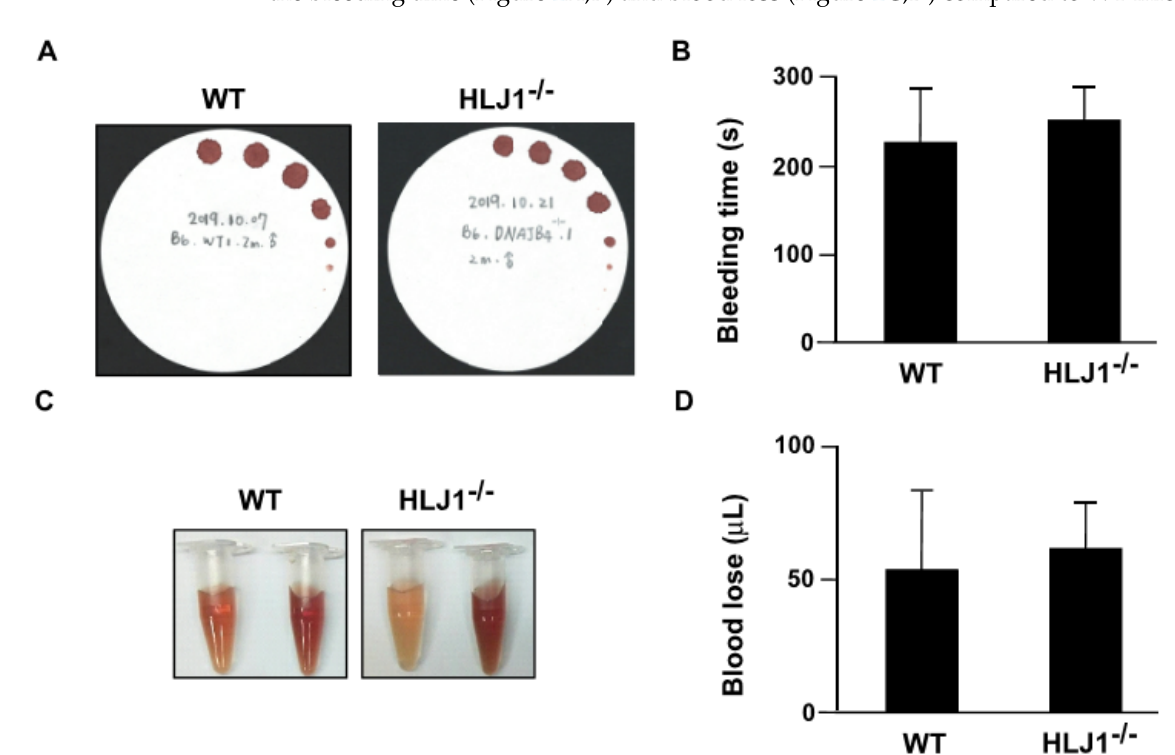
Figure 2. Tail bleeding time and blood loss in WT and HLJ1 -/- mice. ( A , B ) Tail bleeding time was assessed by the filter paper method in WT and HLJ1 -/- mice. ( C , D ) Blood loss after tail transection was measured in WT and HLJ1 -/- mice. Data are the mean ± SEM from 9 mice.